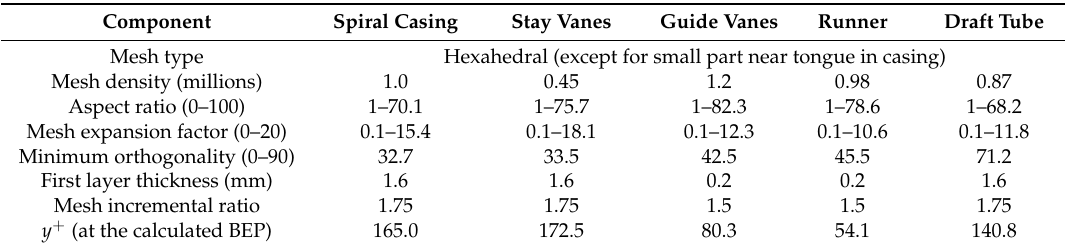
Table 5. Statistics and quality of the mesh. BEP: best efficient